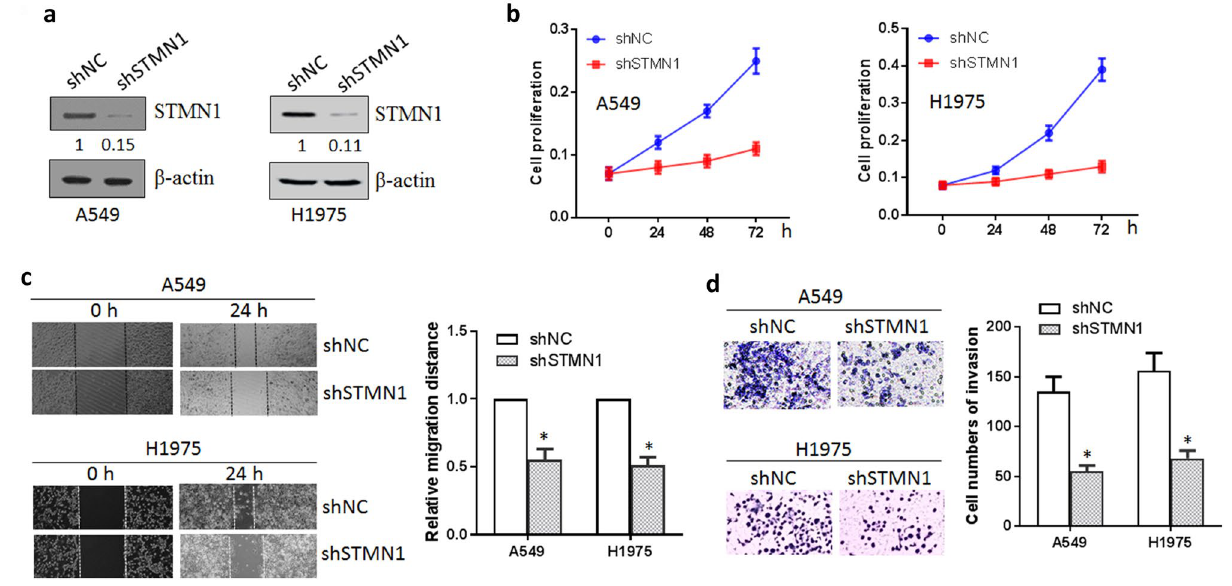
Figure 2. Inhibition of STMN1 suppressed the growth, migration and invasion of lung cancer cells. ( a ) Knockdown of SMN1 in A549 and H1975 cells was measured by western blotting. Full-length images are presented in Supplementary Fig. 2. ( b ) Cell proliferation was decreased after knockdown of STMN1 in A549 and H1975 cells. ( c ) Silencing of STMN1 inhibited the migration ability of A549 and H1975 cells. * p < 0.05. ( d ) Silencing of STMN1 also inhibited A549 and H1975 cells invasion. * p < 0.05.